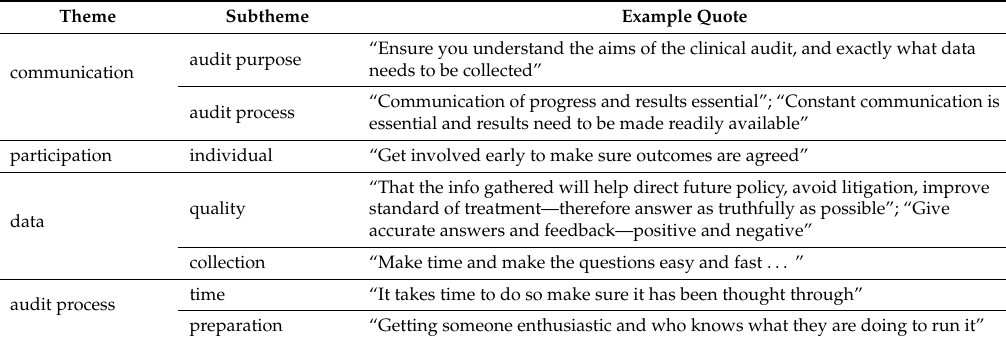
Table 4. Advice from veterinary surgeons who have participated in clinical audit for veterinary surgeons who are about to participate in a clinical audit set up by somebody else. Taken from a survey investigating the experiences and attitudes of UK farm animal clinicians towards clinical